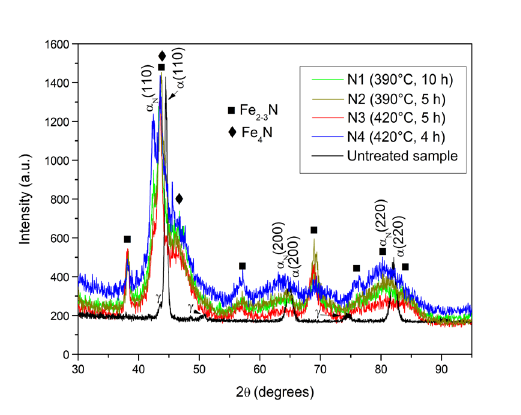
Figure 2. Diffractograms of different nitrided